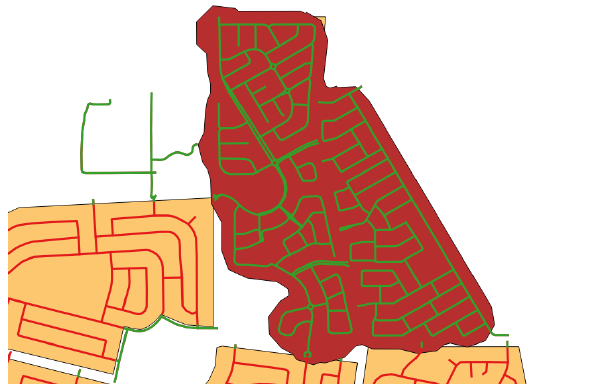
Figure 12. OSM residential roads (red: removed road segments after computing the difference with the resulting polygons of algorithm 1 [depicted in light orange]; green: remaining roads) and the resulting built-up areas (in brown) computed with an initial buffer distance y of 75m and a generalization distance of 5m (area of Darwin, Australia) Figure 15. Combined and generalized built-up areas for Darwin, Australia (buffer distance z =